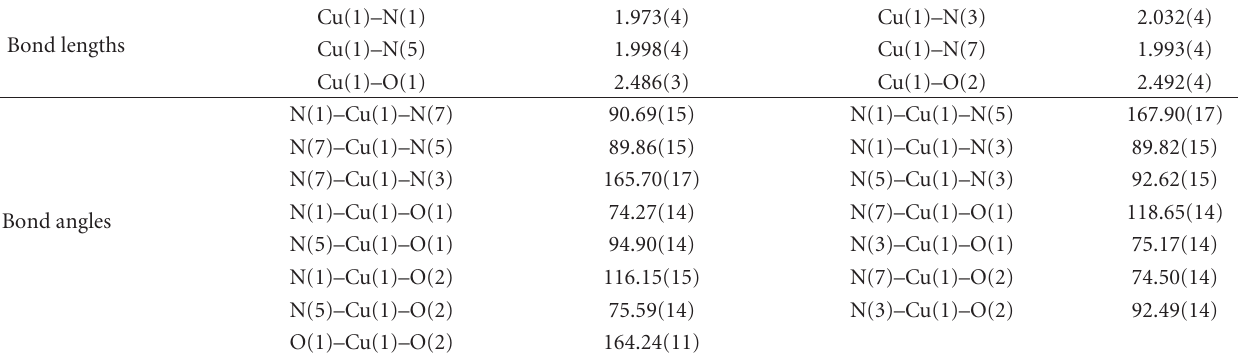
Table 2: Selected bond lengths (˚A) and angles ( ◦ ) for [Cu(buobb) 2 ](pic) 2 · 2DMF. Bond lengths